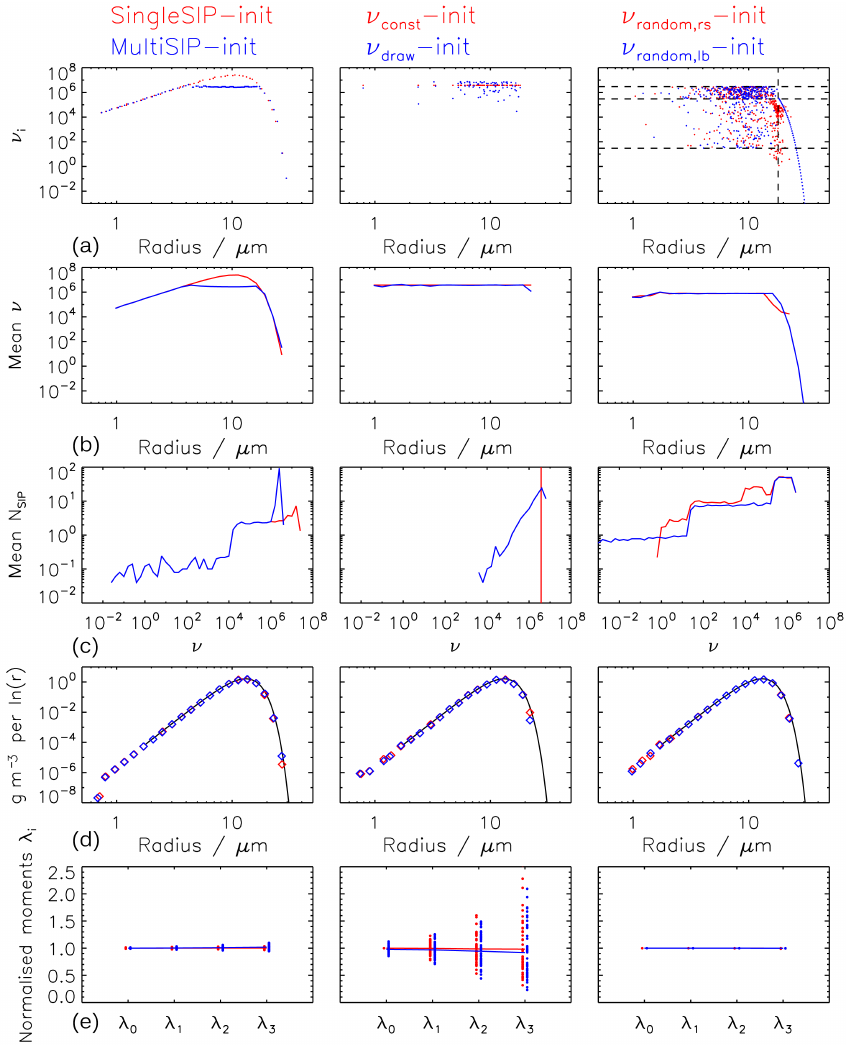
Figure 1. Characteristics of the various SIP initialisation methods (as given on top of each panel): weighting factors ν i (r i ) of an initial ν(r) , the occurrence frequency of the ν i values and the resulting mass density distributions g ln r SIP ensemble, the mean weighting factors ¯ are displayed (rows 1 to 4). Row 1 displays data of a single realisation, whereas rows 2 to 4 show averages over 50 SIP ensembles. The bottom row shows the moments λ 0 , λ 1 , λ 2 and λ 3 normalised by the respective analytical value. Every symbol depicts the value of a single realisation. The nearly horizontal line connects the mean values over all realisations. In the displayed examples, κ κ 10 , ν critmax 2 . 6 10 6 in the multiSIP-init, N SIP 80 in the ν const , ν draw -init and (α high ,α med ,α low ) = ≈ × = inits. In top right panel, the dashed horizontal lines indicate the values of N 10 α low , N 10 α med and N 10 α high and the dashed vertical line the threshold radius r lb